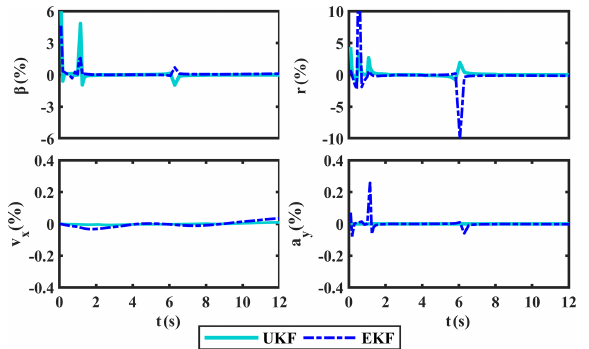
Figure 14. The estimated results of β , r , v x , and a y under fishhook manoeuver test II.